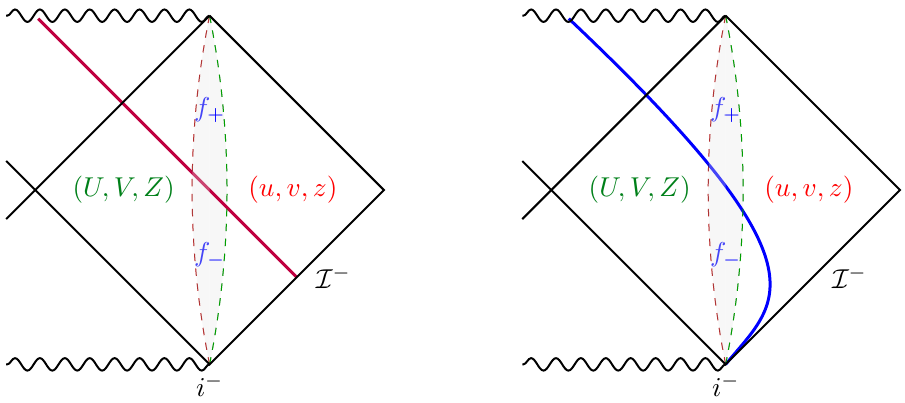
ˆ f = f + − f − in the soft hair